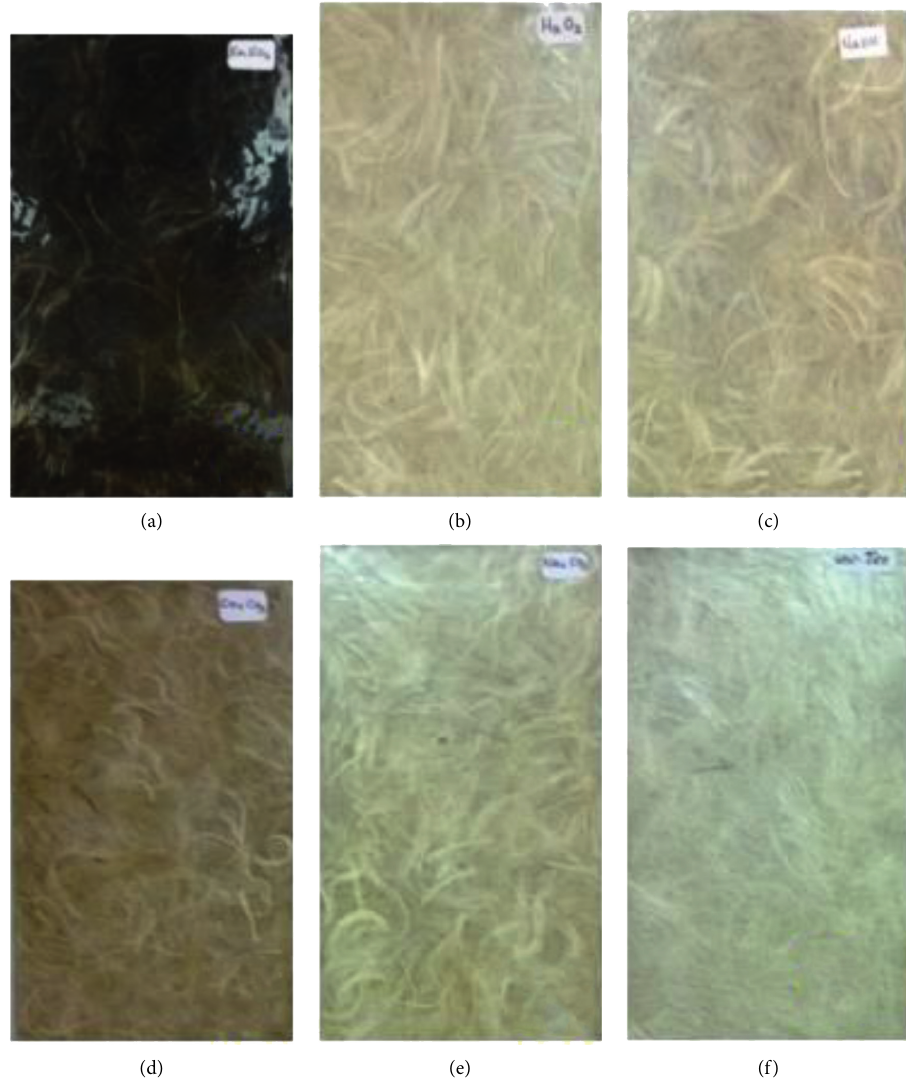
Figure 1: Fabricated composite materials: (a) potassium permanganate-treated composite, (b) hydrogen peroxide-treated composite, (c) alkali (NaOH) treated composite, (d) calcium carbonate-treated composite, (e) sodium carbonate composite, and (f) untreated